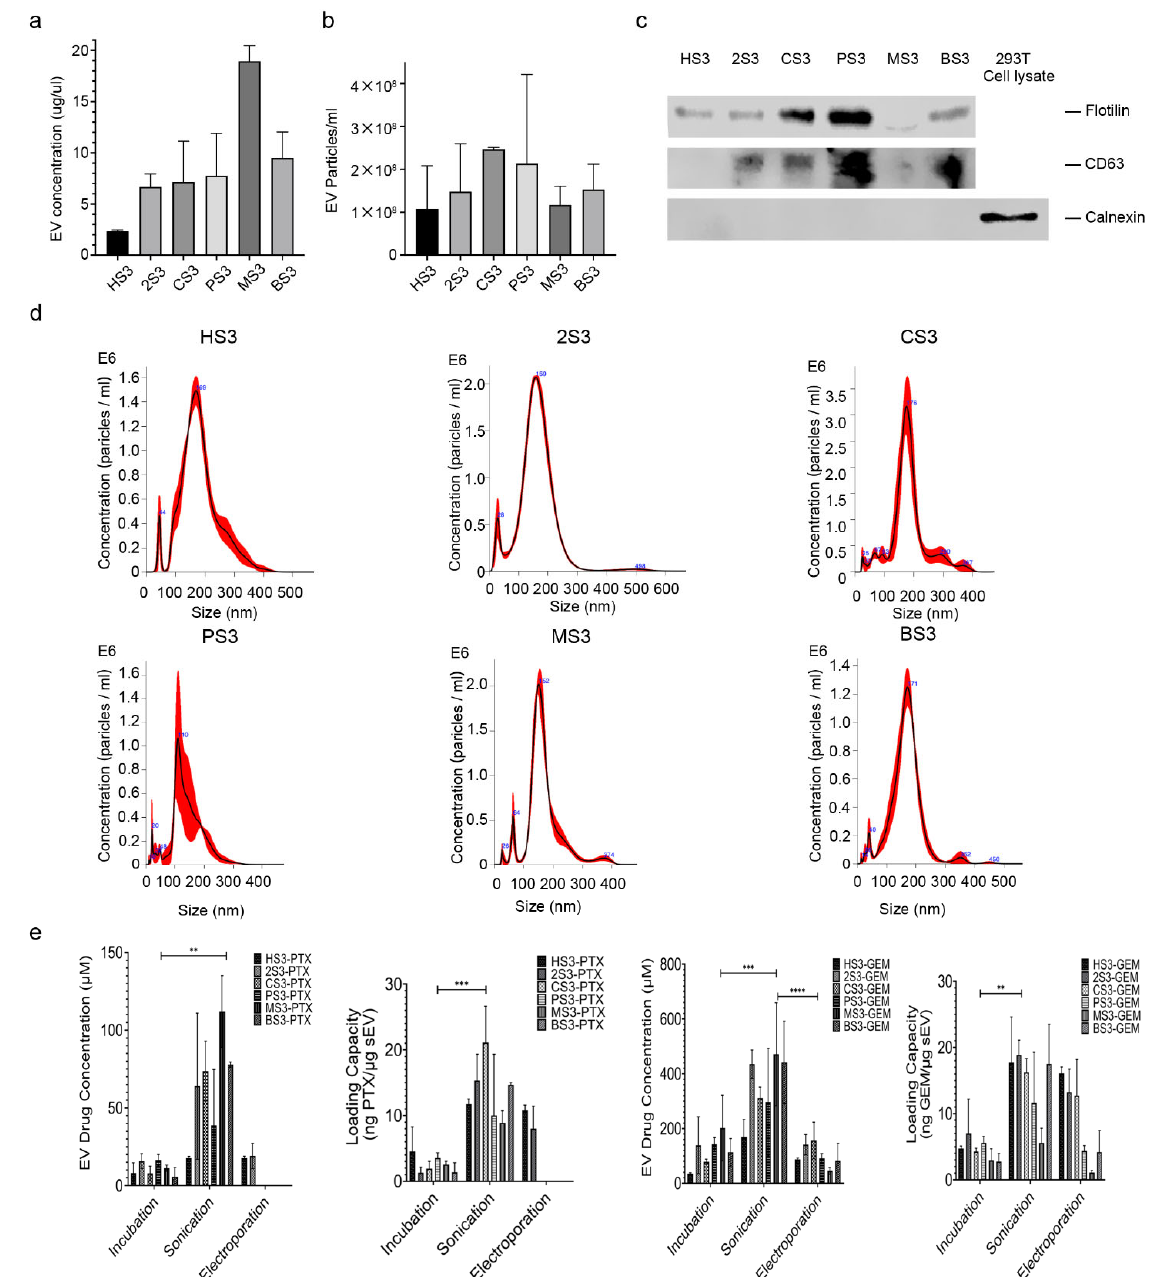
Figure 1. Validation of extracellular vesicles and quantification of EV drugs. ( a ) EVs were derived from 20 mL medium of 6 different human cell lines, and EV concentrations were analyzed by BCA assay; ( b ) EV particle analysis by NanoSight (1:1000 dilution); ( c ) Small EV ‐ positive markers, CD63 and Flotillin ‐ 1, and a negative marker, Calnexin, detected by Western blot; ( d ) Representative EV size distribution and particle numbers analyzed by Nanosight; ( e ) Sonication leads to higher efficiency of EV drug loading than incubation and electroporation. **** p < 0.0001, *** p < 0.001, ** p < 0.01, one ‐ way ANOVA ( n = 3–5, comparison of Incubation, Sonication, and Electroporation). HS3: HPNE sEV; 2S3: HEK ‐ 293T sEV; CS3: CAF19 sEV; PS3: PANC ‐ 1 sEV; MS3: MIA PaCa ‐ 2 sEV; BS3: BxPC ‐ 3 sEV; PTX: Paclitaxel; GEM: Gemcitabine.